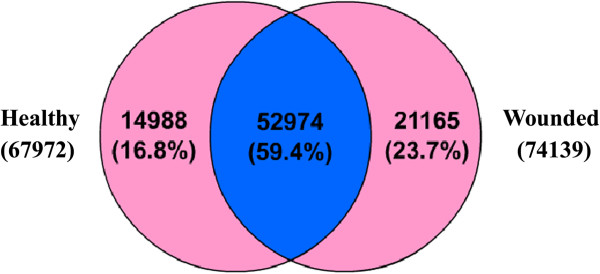
Comparison of the unigenes expressed in the healthy and wounded tissue libraries. The overlapping section represents the 52,974 (59.43%) unigenes that were found in both libraries; 14,988 (16.83%) unigenes were expressed only in the healthy library, and 21,165 (23.74%) unigenes were expressed only in the wounded library.